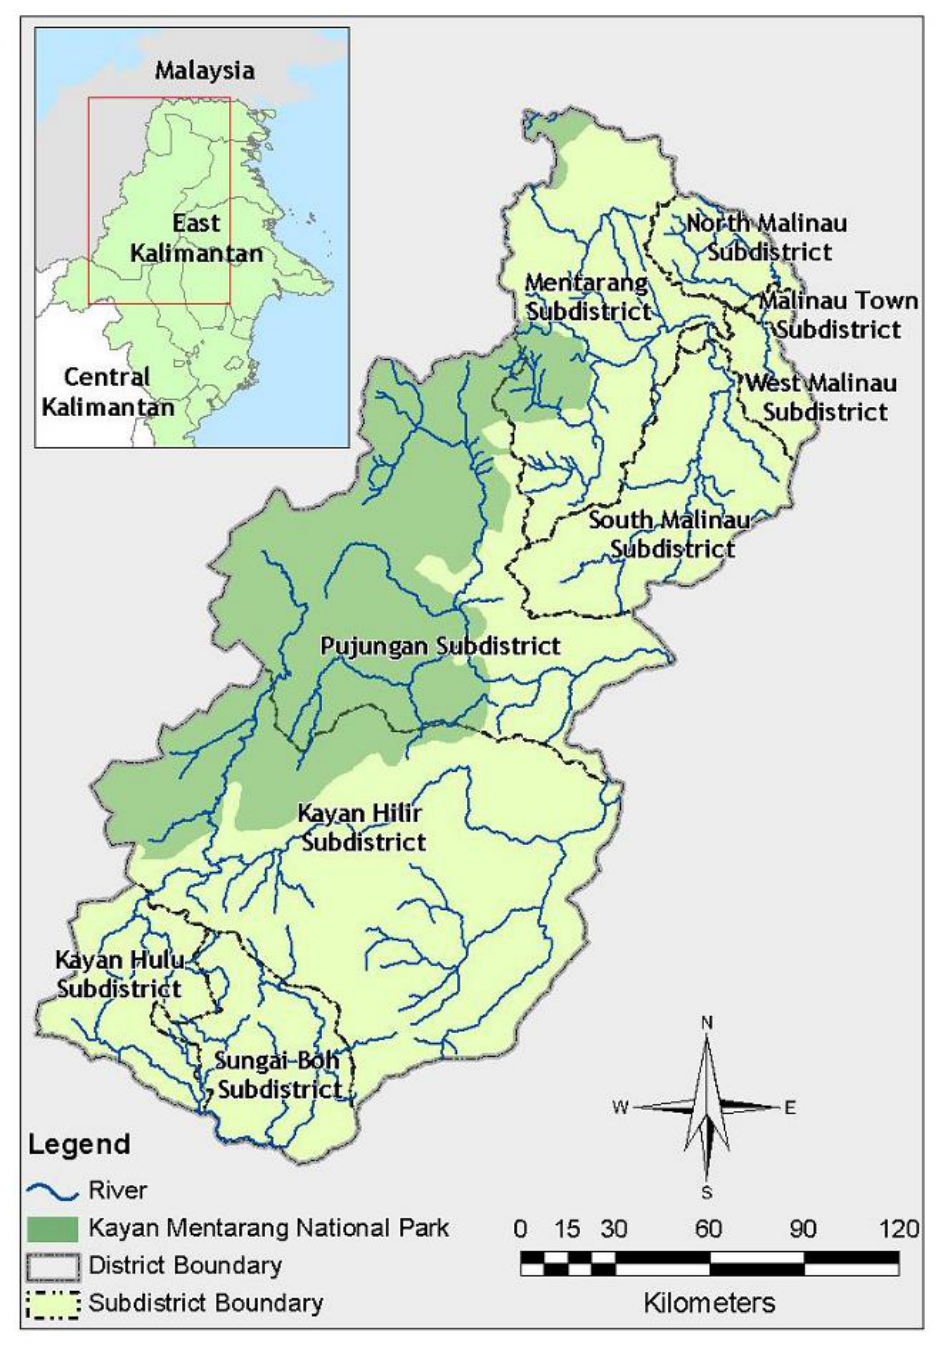
Fig. 1. Geographical features of Malinau District (Source: Topografi Kodam (TOPDAM) 2004 and Badan Perencanaan Pembangunan Daerah (Bappeda)